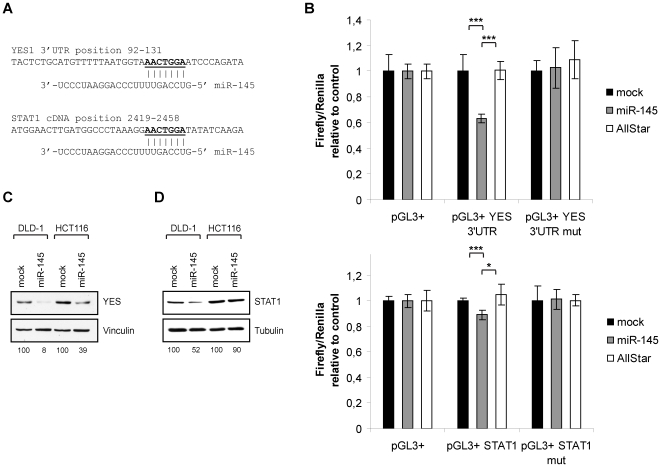
Targets validation of YES and STAT1.
A, Sequence alignment of the miR-145 seed region and mRNA targets. The position coordinates are indicated for the transcript isoforms listed below. YES1 3′UTR: ENSG00000176105:ENST0000035983 STAT1 cDNA: ENSG00000115415:ENST00000361099. B, Firefly luciferase assay with pGL3+ constructs holding a 3′UTR fragment of YES or a cDNA fragment of STAT1, downstream to the firefly luciferase gene. Cells were co-transfected with firefly luciferase reporters along with a Renilla luciferase transfection control plasmid either alone or with 50 nM miR-145 duplex and 50 nM AllStar duplex as a negative control. In pGL3+ mut vectors two base pairs in the miR-145 seed site have been mutated. Luminescence was measured 24 hours post-transfection and the ratio of the firefly to the Renilla activity is shown relative to transfection without RNA duplex and the empty vector. Data are shown as the mean ± S.D. of four replicates. *, p<0.05 using a two-tailed t-test, ***, p<0.01 using a two-tailed t-test. C and D, Western blot analysis of DLD-1 and HCT116 cells transfected with miR-145 duplexes or mock transfected cells blotted for YES (C) and STAT1 (D). Vinculin or tubulin were used as loading controls. The bands were quantified relative to the appropriate loading controls using the TotalLab software and are shown relative to the protein level in mock transfected cells. The data shown are representative of two experiments.